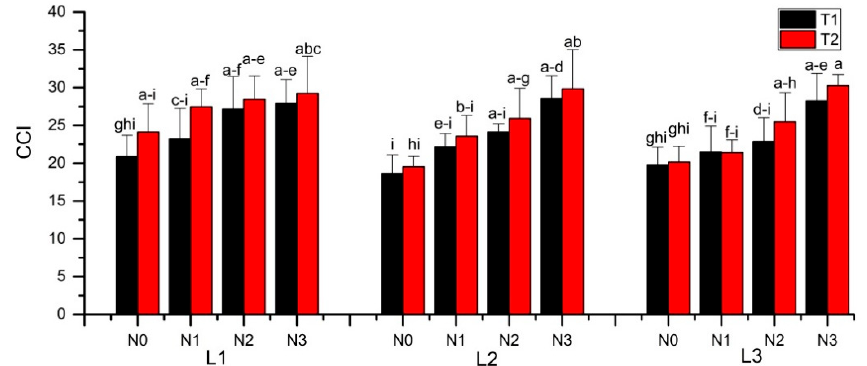
Figure 3. CCI of pakchoi leaves in different treatments. Error bars represent the standard error of the means ( n = 3). Bars with different letters lowercase are significantly different according to the Duncan test at p < 0.05.